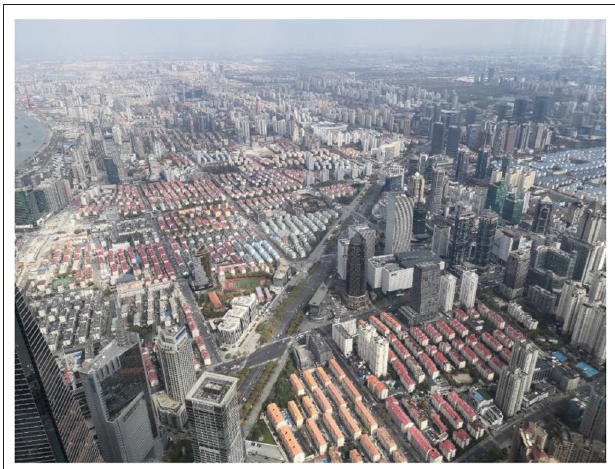
FIGURE 4 | A typical arrangement of mid to high-rise housing compound with a podium of commercial/retail units on the edges and north-south orientation (source: authors’ own).